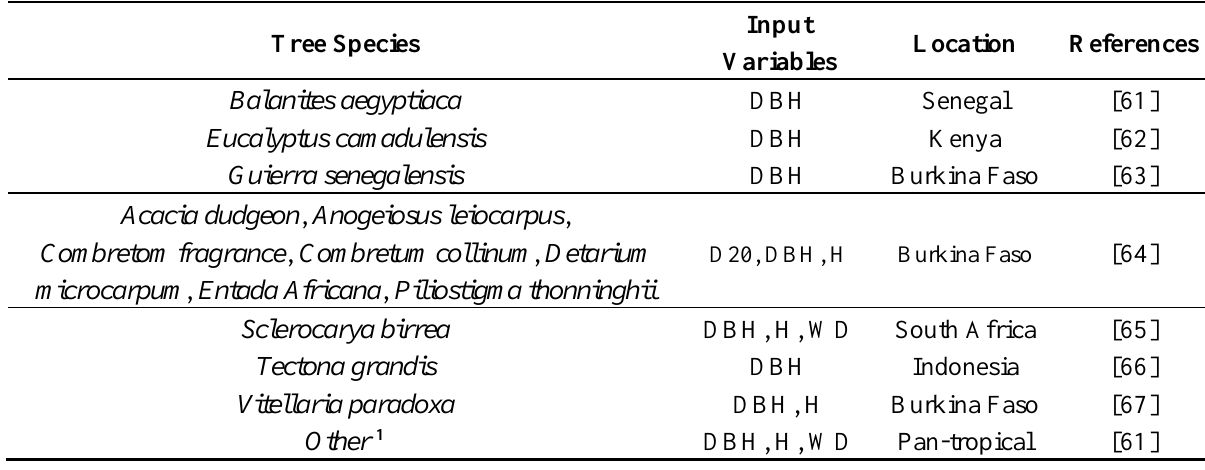
Table 2. Description of allometric equations used for deriving tree level aboveground biomass. DBH—diameter at breast height; D20—diameter at 20 cm; H—height; WD—wood